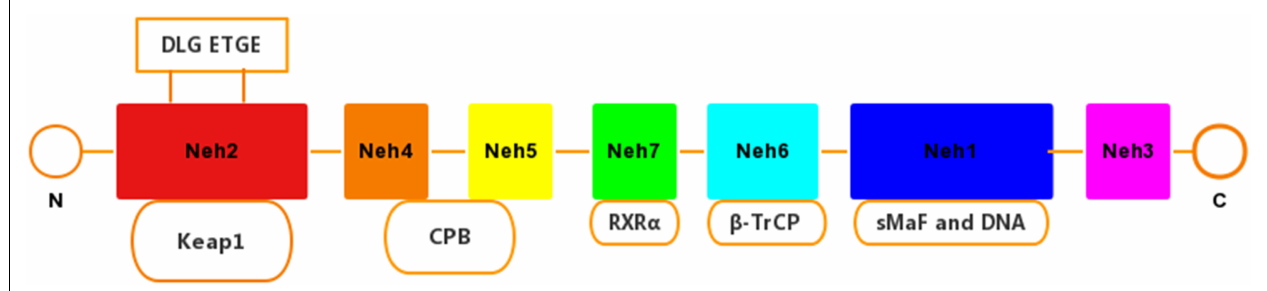
FIGURE 1 | Domain structures of Nrf2. The Nrf2 protein contains seven domains, Nehl–Neh7. The ETGE and DLG motifs in the Neh2 domain are essential for the direct interaction with the Kelch domain of